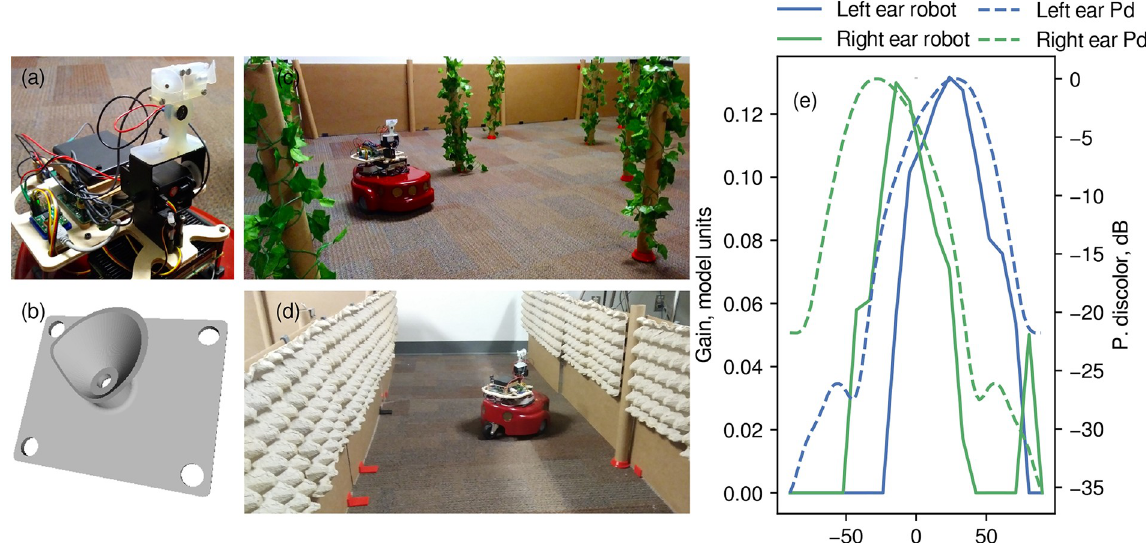
Fig 1. (a) Close up of the robot showing the housing containing the emitter and two microphones in artificial pinnae. Below this, the pan-tilt system can be seen. (b) 3D rendering of one of the artificial pinnae. (c) View of the robot in the rectangular arena. (d) View of the robot in the corridor lined with egg cartons. (e) The gain of the ears as a function of azimuth angle. This plot depicts the output of the cochlear model for a single cardboard tube reflector at 1 m distance from the robot showing the directionality of the robot’s sonar system. Overlaid is the directionality of the bat P. discolor at elevation = 0˚ and 40 kHz, simulated data from Vanderelst et al. [18].